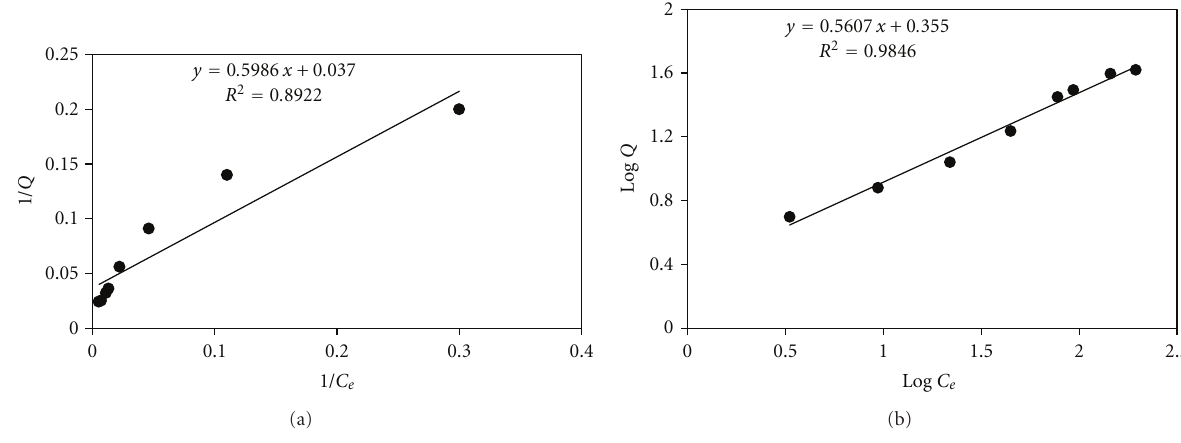
Figure 6: Langmuir (a) and Freundlich (b) adsorption isotherms for Oscillatoria sp. Table 3: Cd(II) statistical parameters in the simulated real samples for di ff erent amounts of dried biomass of Oscillatoria sp. Oscillatoria sp.